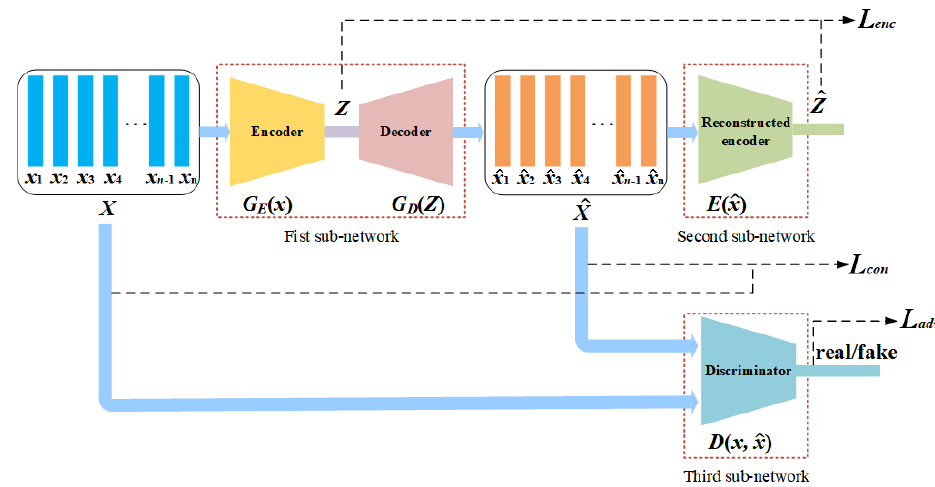
Figure 4. The network structure of GANomaly-LSTM.